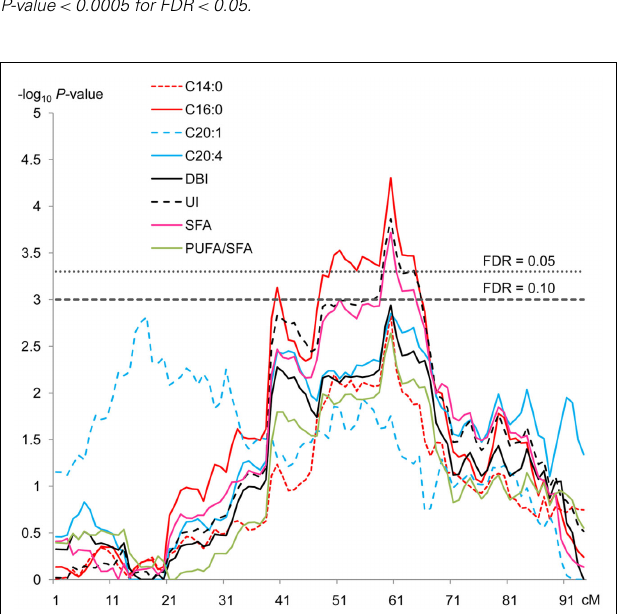
chain length, such as lauric (C12:0) and myristic (C14:0; Li